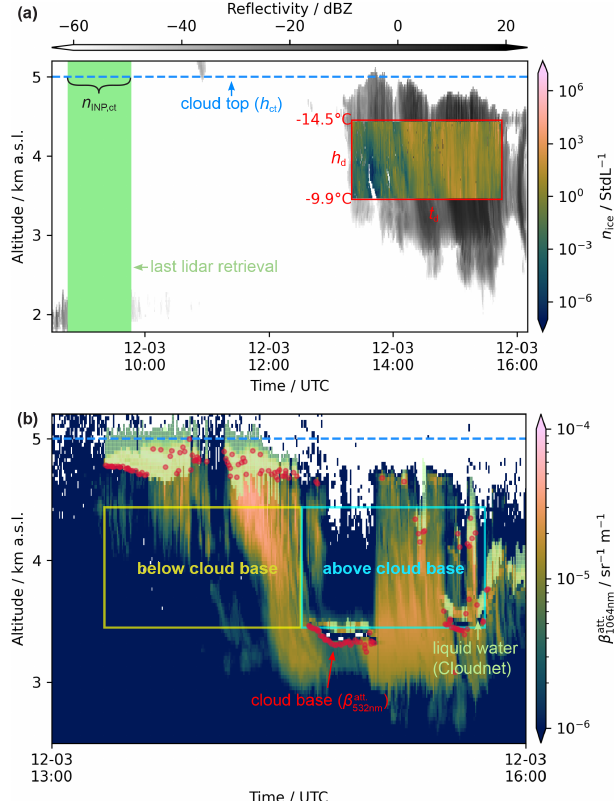
Figure 9. Exemplary illustration of data processing workflow to obtain in-cloud ice multiplication factors (IMFs) for the cloud ob- served on 12 March 2019. (a) Reflectivity of the cloud radar is given in shades of gray. Ice crystal number concentration ( n ice ) is overlaid in color. The limit of used data for the IMF calculation with height is indicated in red (height span h d , time span t d ). Additionally, the ambient temperature at the heights of the upper and lower bounds of selected data is given in red (see T dt and T db in Table D1). The INP concentration ( n INP , ct ) was taken from the last lidar retrieval (solid green shading) at cloud top (dashed blue line). (b) Attenuated backscatter coefficient at 1064nm ( β att . ) from the lidar in color. 1064nm Cloud base estimates determined from the attenuated backscatter coefficient at 532nm ( β att . ) are indicated by red dots. Regions 532nm where the Cloudnet algorithm detected liquid water are indicated in bright green. The height of cloud top is indicated by the dashed blue line. The region within the yellow rectangle was classified as below cloud base and the region within the cyan rectangle as above cloud base. Overviews of all individual cloud events can be found in Figs. B1 and